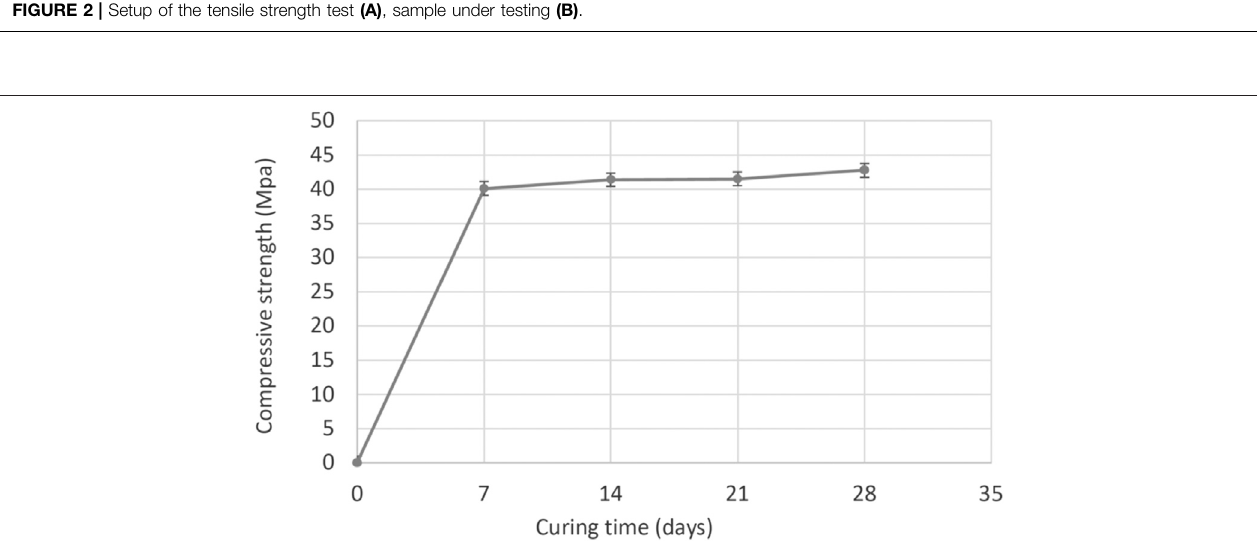
FIGURE 2 | Setup of the tensile strength test (A) , sample under testing (B) .